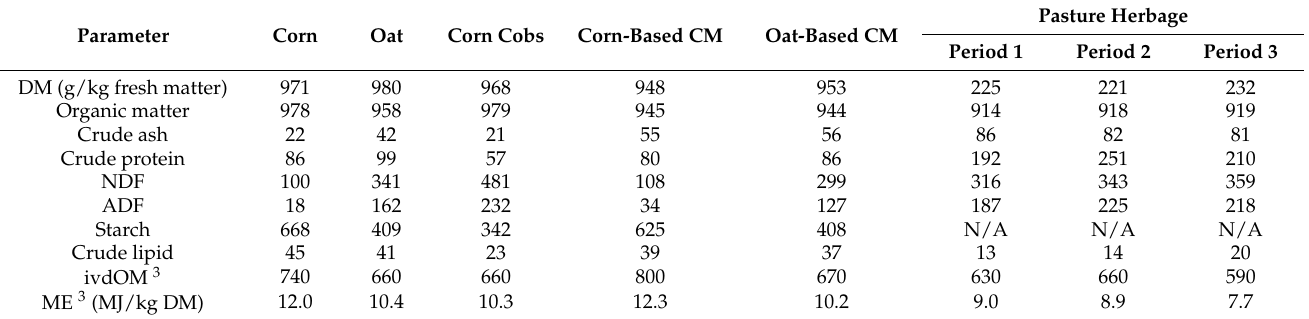
Table 2. Chemical composition (g/kg DM) of ingredients 1 , CM 2 , and pasture herbage offered to lactating Brown Swiss cows grazing a mixed alfalfa-ryegrass sward and supplemented with a corn- or an oat-based CM before or after grazing ( n = 3